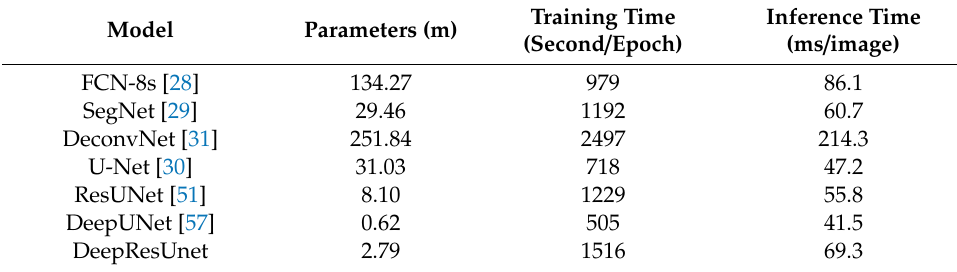
Table 4. Complexity comparison of FCN-8s, SegNet, DeconvNet, U-Net, ResUNet, DeepUNet and the proposed